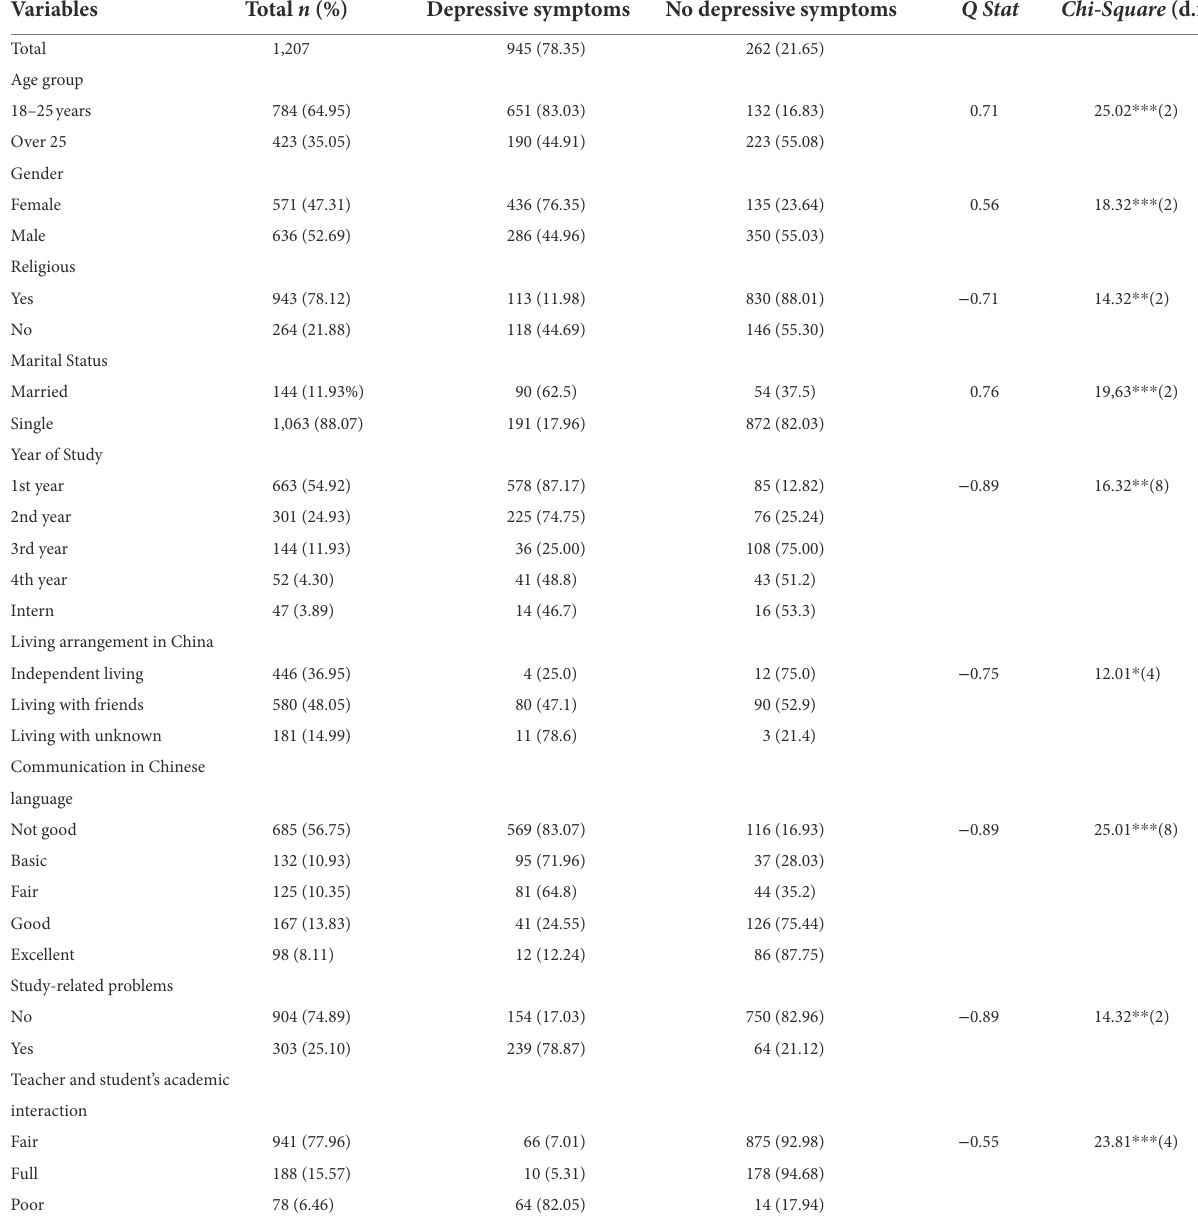
TABLE 1 Association between participants background characteristics and depressive